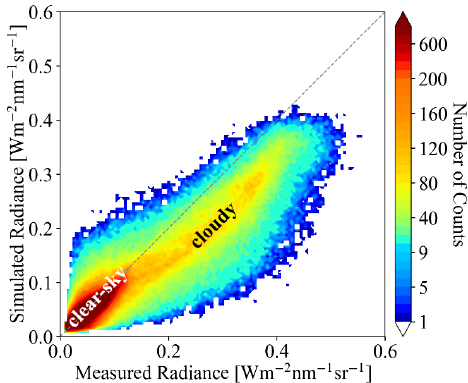
Figure 7. Heatmap plot of EaR 3 T simulated 3D radiance versus MODIS measured radiance at